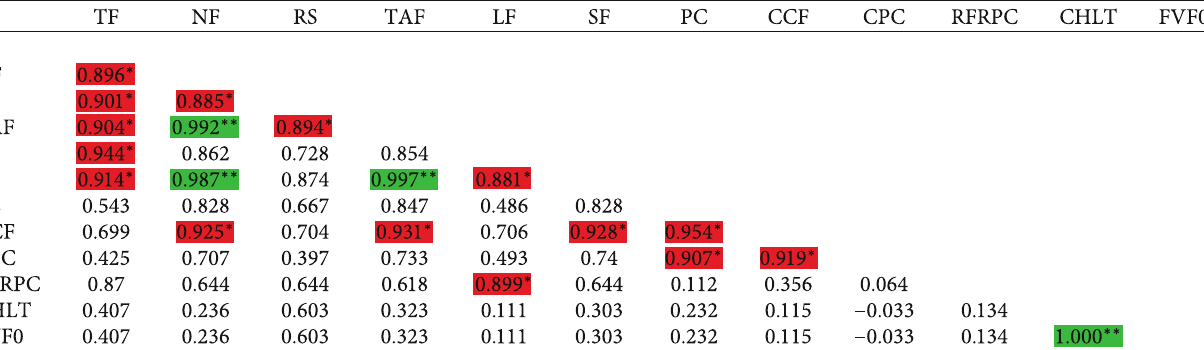
Figure 3: Contribution of factors to trait variances in the years 2016-2017 (a) and 2017-2018 (b). TF: flowering rate; NF: number of flowers; RS: stigma yield; TAF: leaf emergence rate; LF: leaf length; SF: leaf area; PC: corm weight; CCF: large daughter corms. Table 7: Matrix of correlations between the different quantitative traits